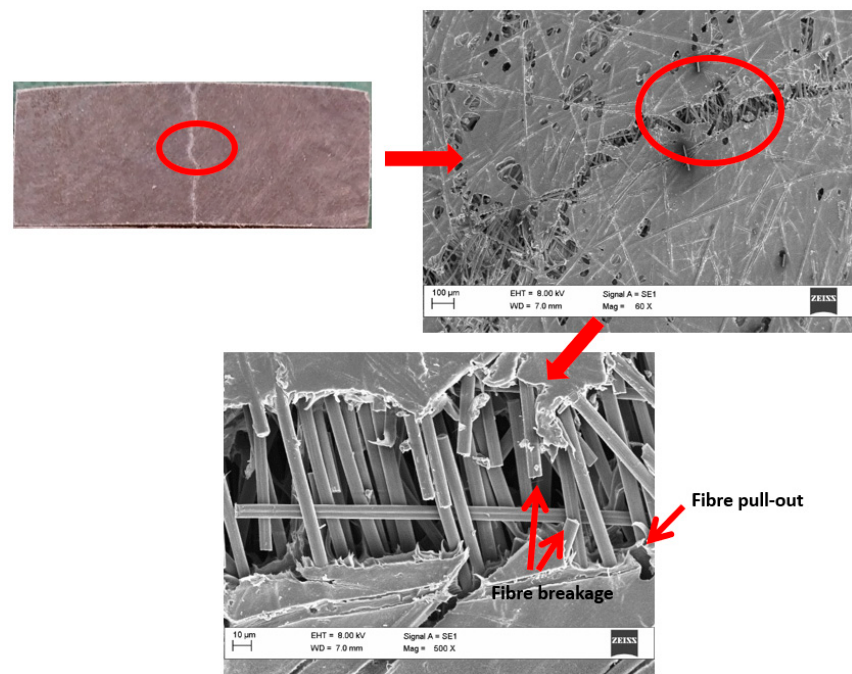
Figure 7. SEM images of the matrix crack of specimen 1-3 in 60× and 500× magnification. Fibre pull-out and breakages are visible.